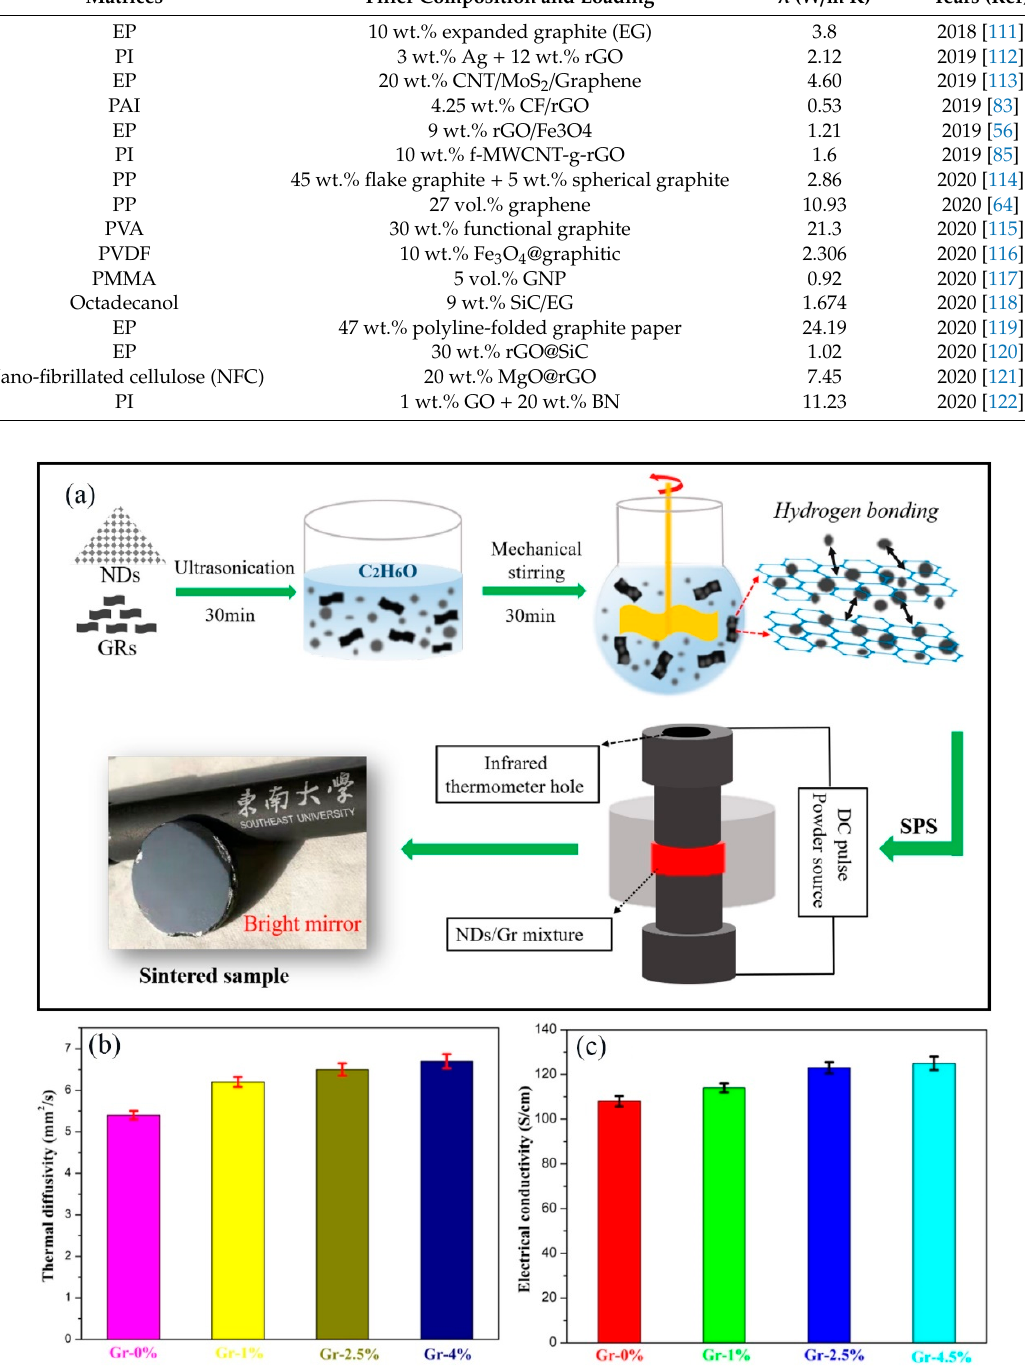
Figure 3. ( a ) Schematic illustration of the preparation process for graphite composites bulks. ( b ) Thermal diffusivity and ( c ) electrical conductivity of sintered samples with different graphene (Gr) contents (reproduced with permission from [108]).